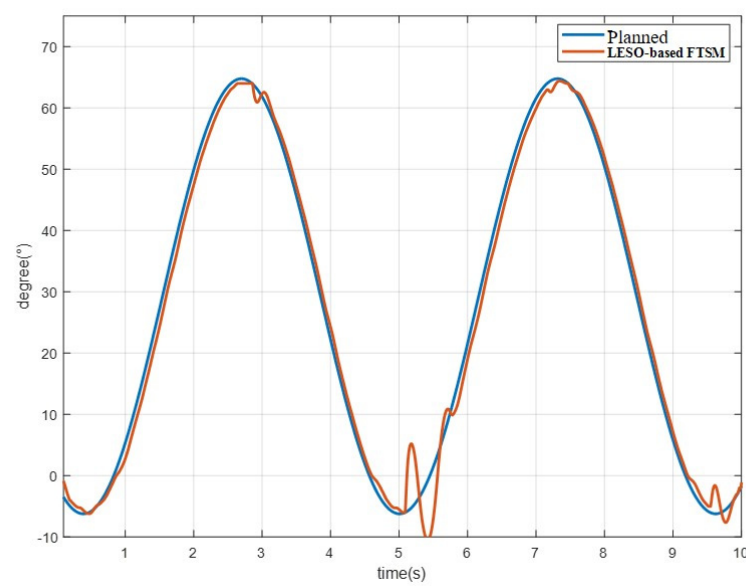
Figure 19. Trajectories of hip joint for ascending by two steps per stride.